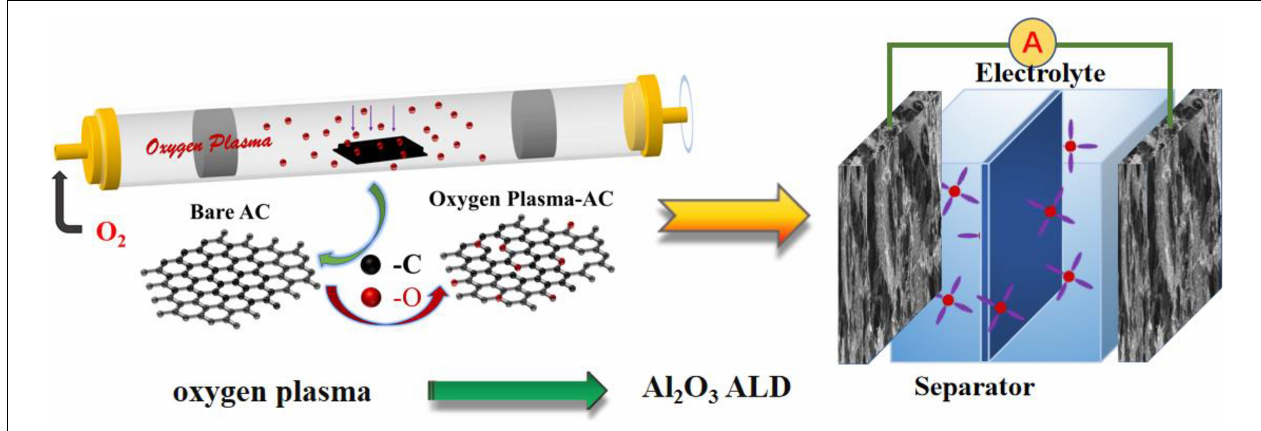
FIGURE 1 | Illustration for the function of oxygen plasma, Al 2 O 3 ALD coating on the AC electrode, and the construction of AC-based symmetric